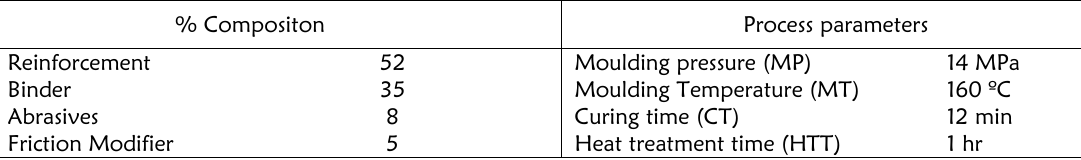
Table 4: Percentage composition and process parameters